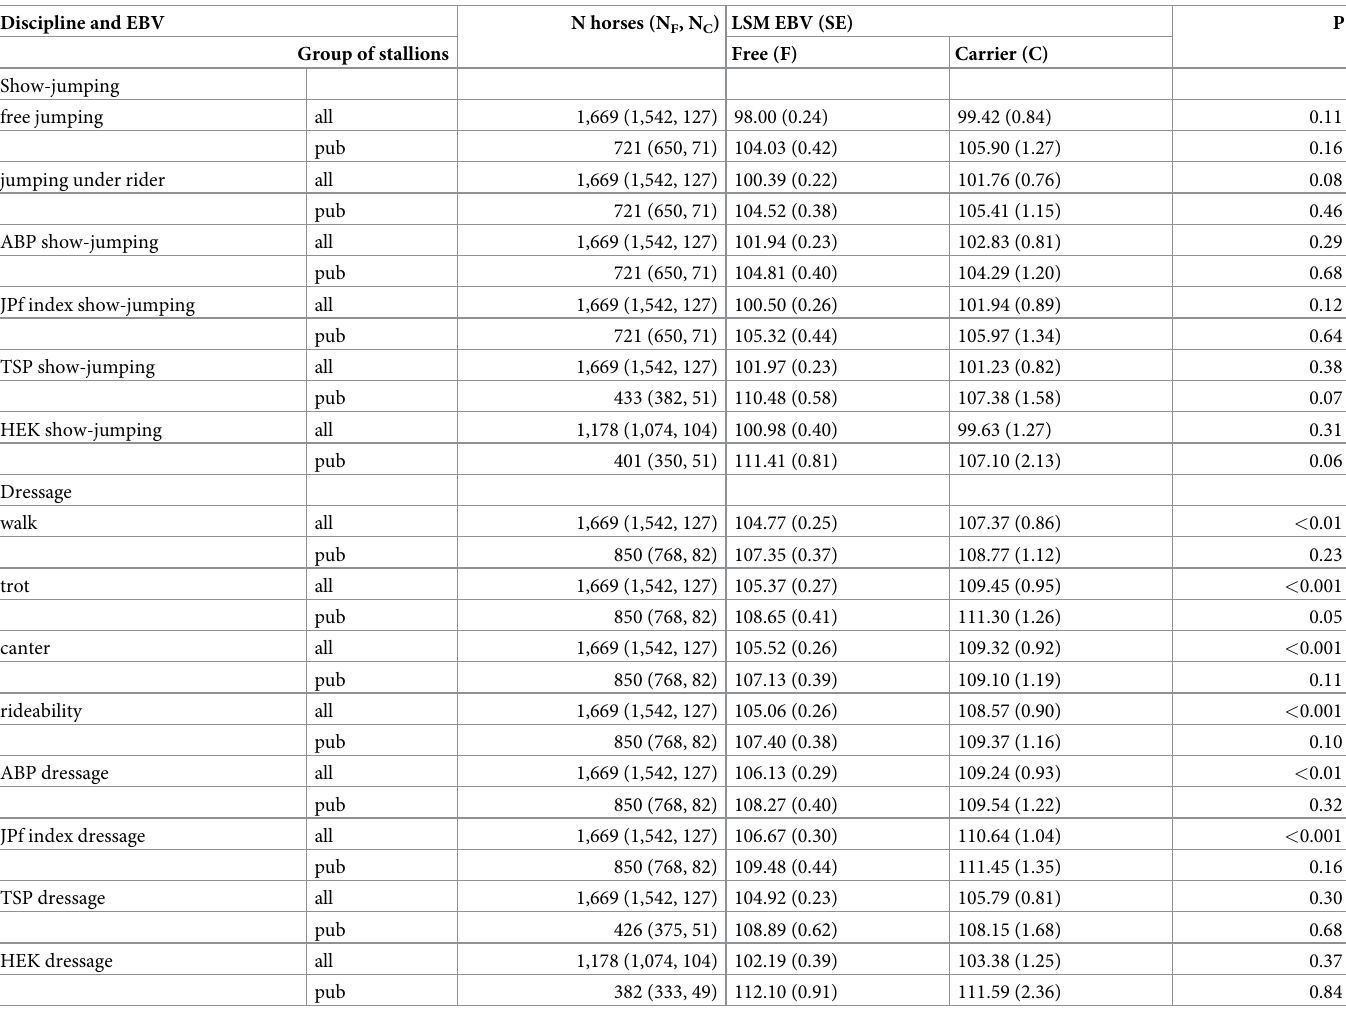
Table 3. Results of the multiple analyses of variance for the estimated breeding values (EBVs) for dressage and show-jumping and the WFFS status, with number of horses in total (N) and by WFFS status (N F , N C ), least square mean estimates (LSM) with respective standard errors (SE) and error probabilities (P) for all stallions with EBVs (all) and for the stallions with published EBVs